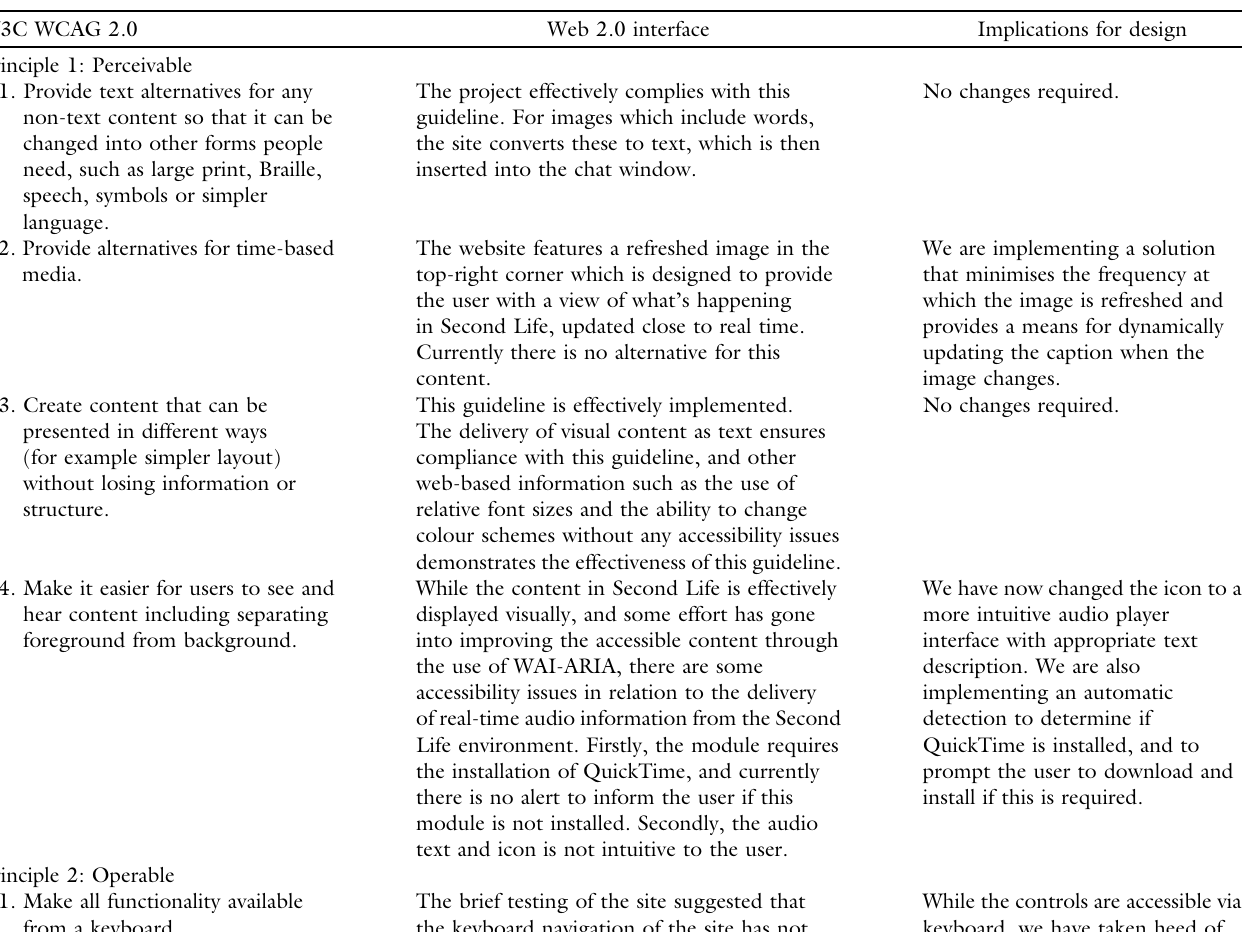
Table 1. Results of accessibility testing of the Web 2.0 interface to the MUVE. W3C WCAG